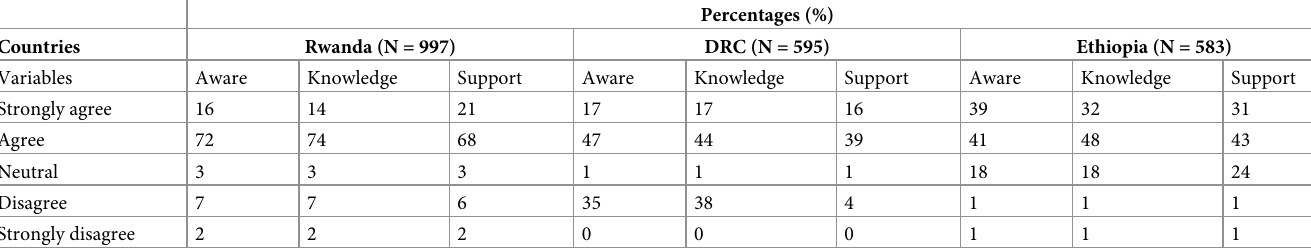
Table 4. Household awareness, knowledge, or support for CBE